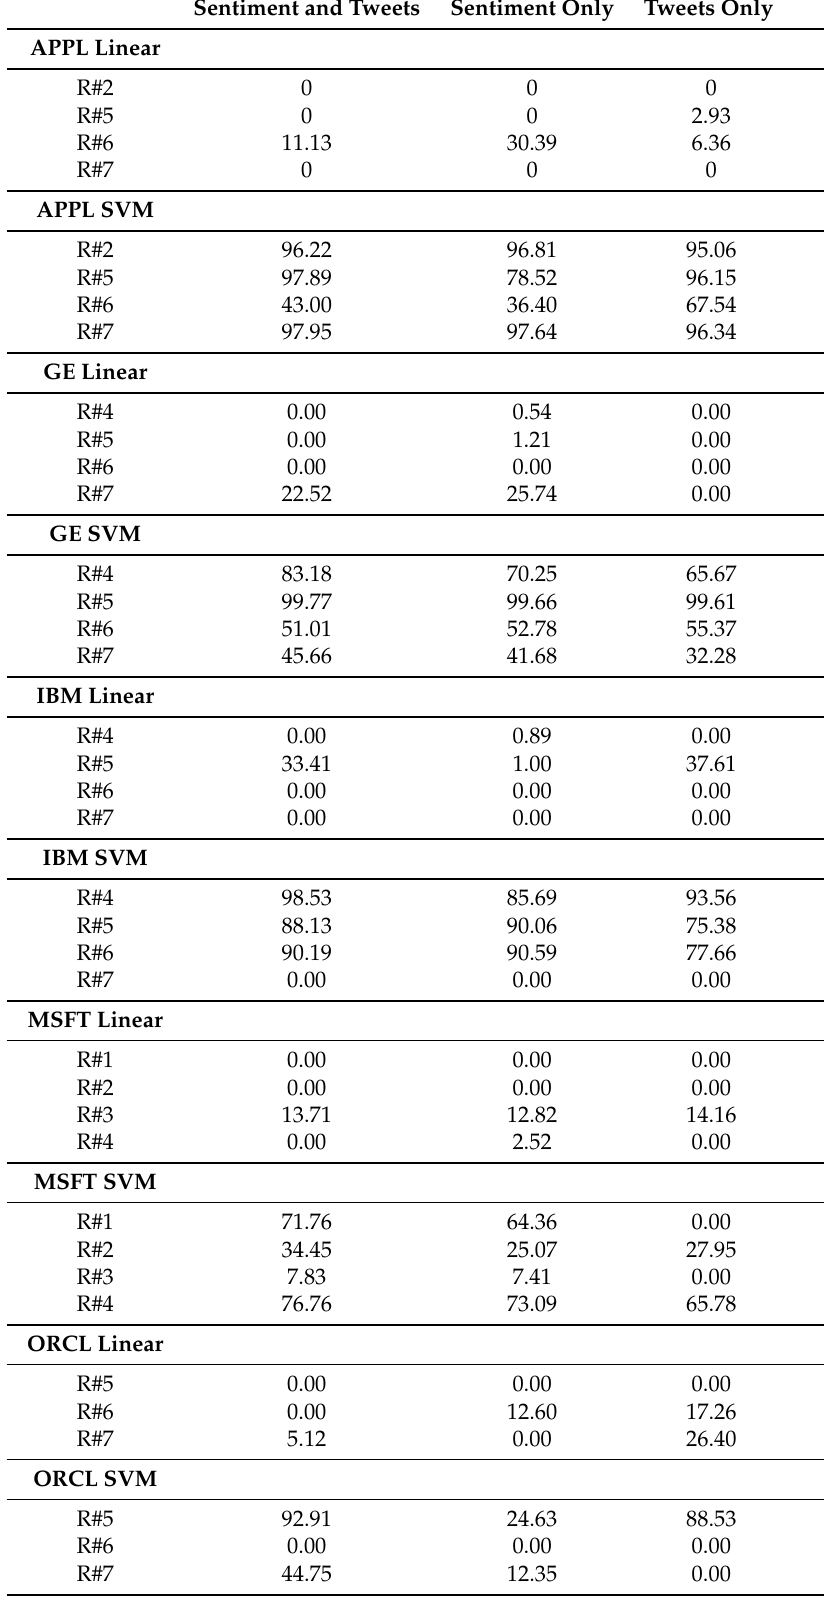
Table 5. The improvement rates of the next closing price of the five companies using rules (in